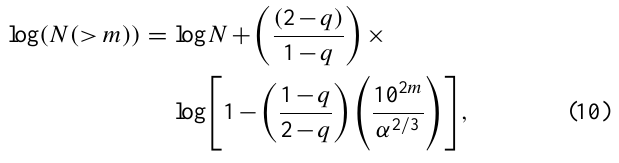
Fig. 2. We use the Gutenberg-Richter law (Equation 5) to calculate the cumulative number of D st data, N ( > m ) (upper panel). There is an agreement of the aforementioned formula for b = 0 . 93 with the D st time series. We then use the Gutenberg-Richter law to calculate the cumulative number of X-ray flux data, N ( > m ) (middle panel). There is an agreement of the aforementioned formula for b = 0 . 94 with the X-ray flux time series. Finally, the Gutenberg-Richter law is used to calculate the cumulative number of pre-seismic EM emission data, N ( > m ) (lower panel). There is an agreement of the aforementioned formula for b = 0 . 57 with the pre-seismic EM emission time series.